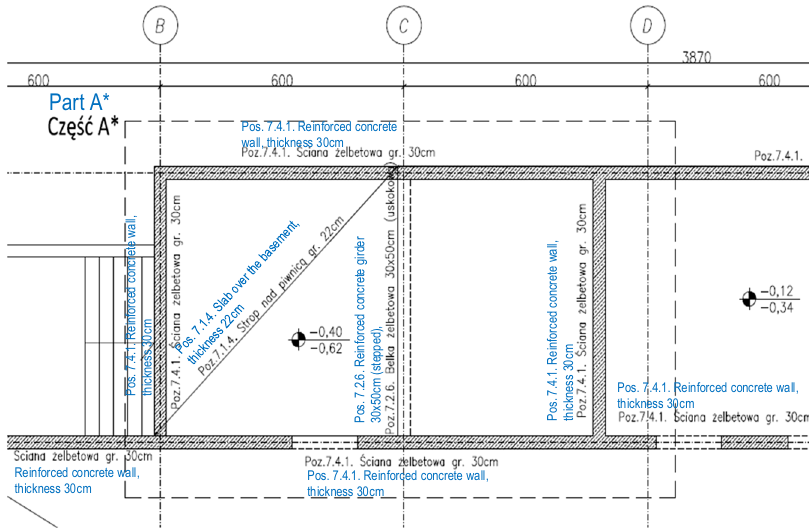
Figure 1: The room marked “ Part A* ” designed from high - density concrete class C30/37, ( documentation AGH university )